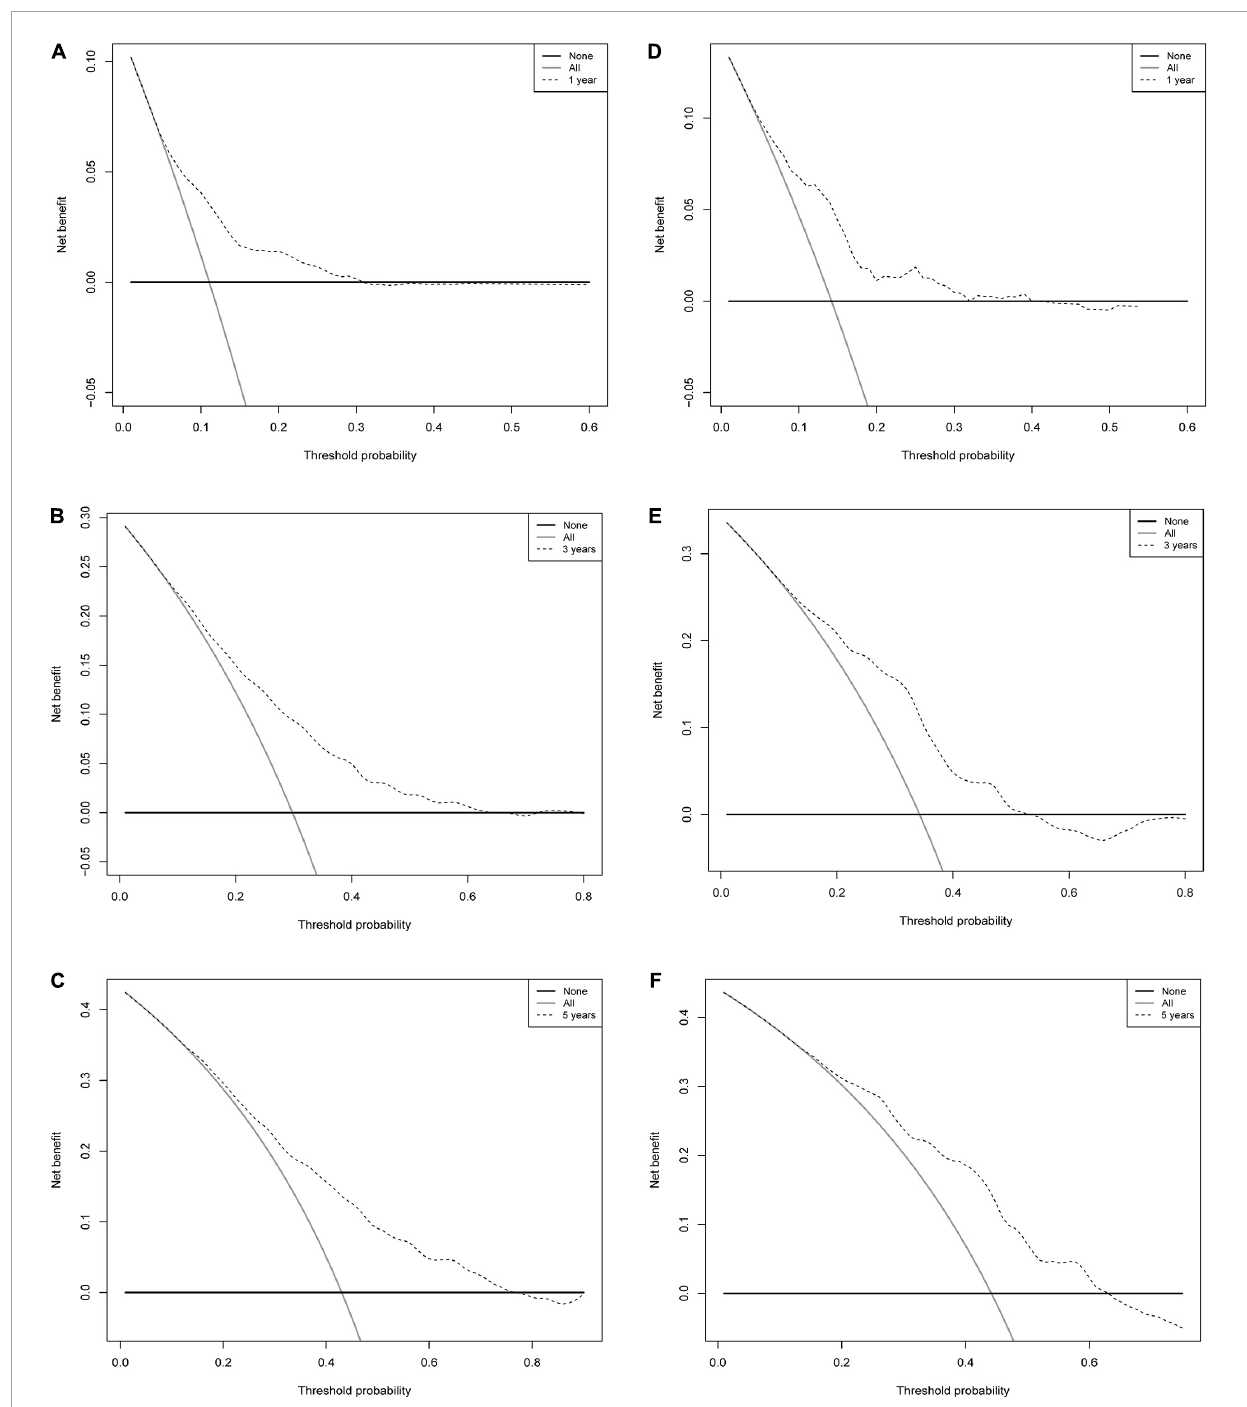
FIGURE6 Decision curve analysis of a nomogram of mortality risk at 1, 3, and 5 years in patients with IHD. (A) Training set 1 year. (B) Training set 3 years. (C) Training set 5 years. (D) Validation set 1 year. (E) Validation set 3 years. (F) Validation set 5 years. The y-axis represents the net benefit. Dashed lines represent the IHD mortality risk nomogram. The thin solid line represents the hypothesis that all patients died. Thin solid lines represent the hypothesis of no patient